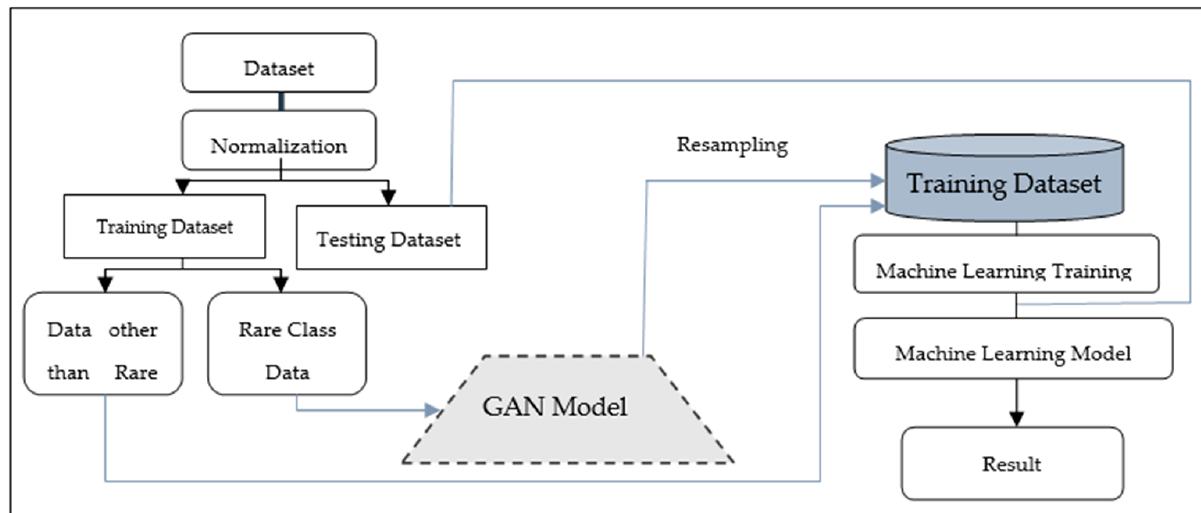
Figure 8. The GAN-RF framework.